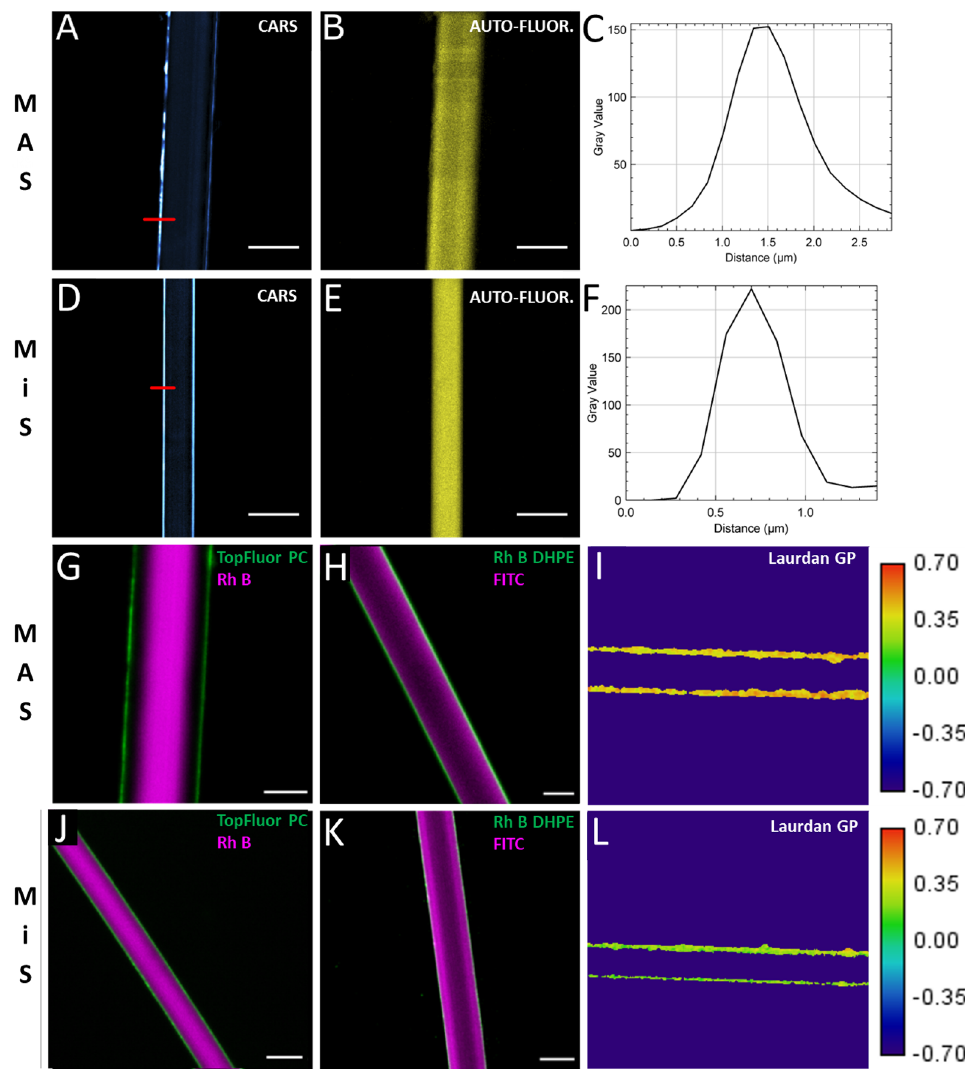
Figure 1. Images of optical sections taken at the middle of MAS and Mis fibres from the orb-weaver spider Nephila madagascariensis. ( A ) CARS image based on the CH 2 -stretch (2850 cm −l ) vibration in a MAS fibre. ( B ) Image of autofluorescence. ( C ) Line profile of the lipid containing layer, see the red line in ( A ). ( D ) CARS image of CH 2 -stretch (2850 cm −l ) in a MiS fibre. ( E ) Corresponding image of autofluorescence. ( F ) Line profile of the lipid containing layer measured along the red line in ( D ). Panels ( G ), ( H ), ( J ) and ( K ) are laser scanning confocal images of an optical section of MAS and MiS spider silk fibres labeled with TopFluor PC (green) and Rhodamine B (magenta) ( G , J ) and FITC (magenta) and Rhodamine B DHPE (green) ( H , K ). ( I , L ) Representative image of Laurdan GP of MAS ( I ) and MiS ( L ) silk fibre labeled with Laurdan, measured using two-photon excitation. Blue regions correspond to a low GP value (fluid phase) and green regions to a higher GP value (liquid-ordered phase) as seen on the color scale to the right. Scalebars are 10